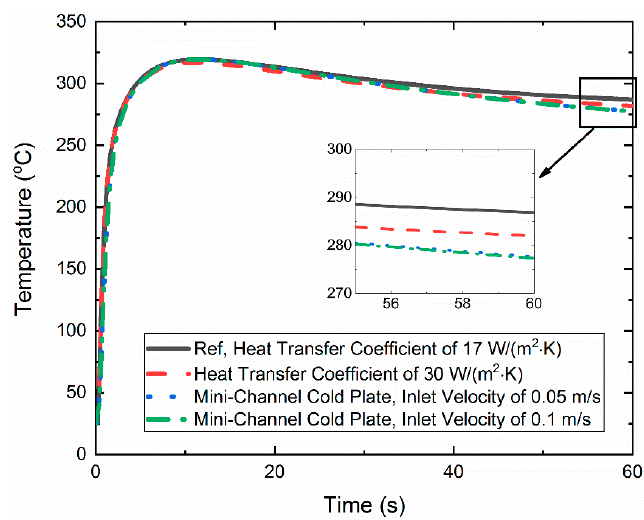
Figure 11. Modeling predicted maximum temperature on lithium-ion battery cell with different cooling schemes.